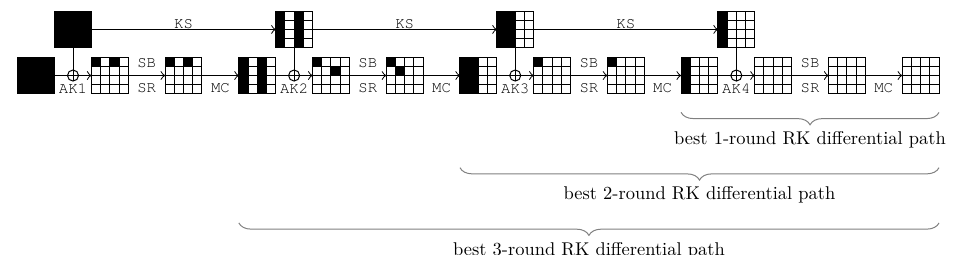
Figure 4: Example of best possible 1/2/3/4-round related-key truncated differential paths for AES-128 . The black/white cells represent active/inactive